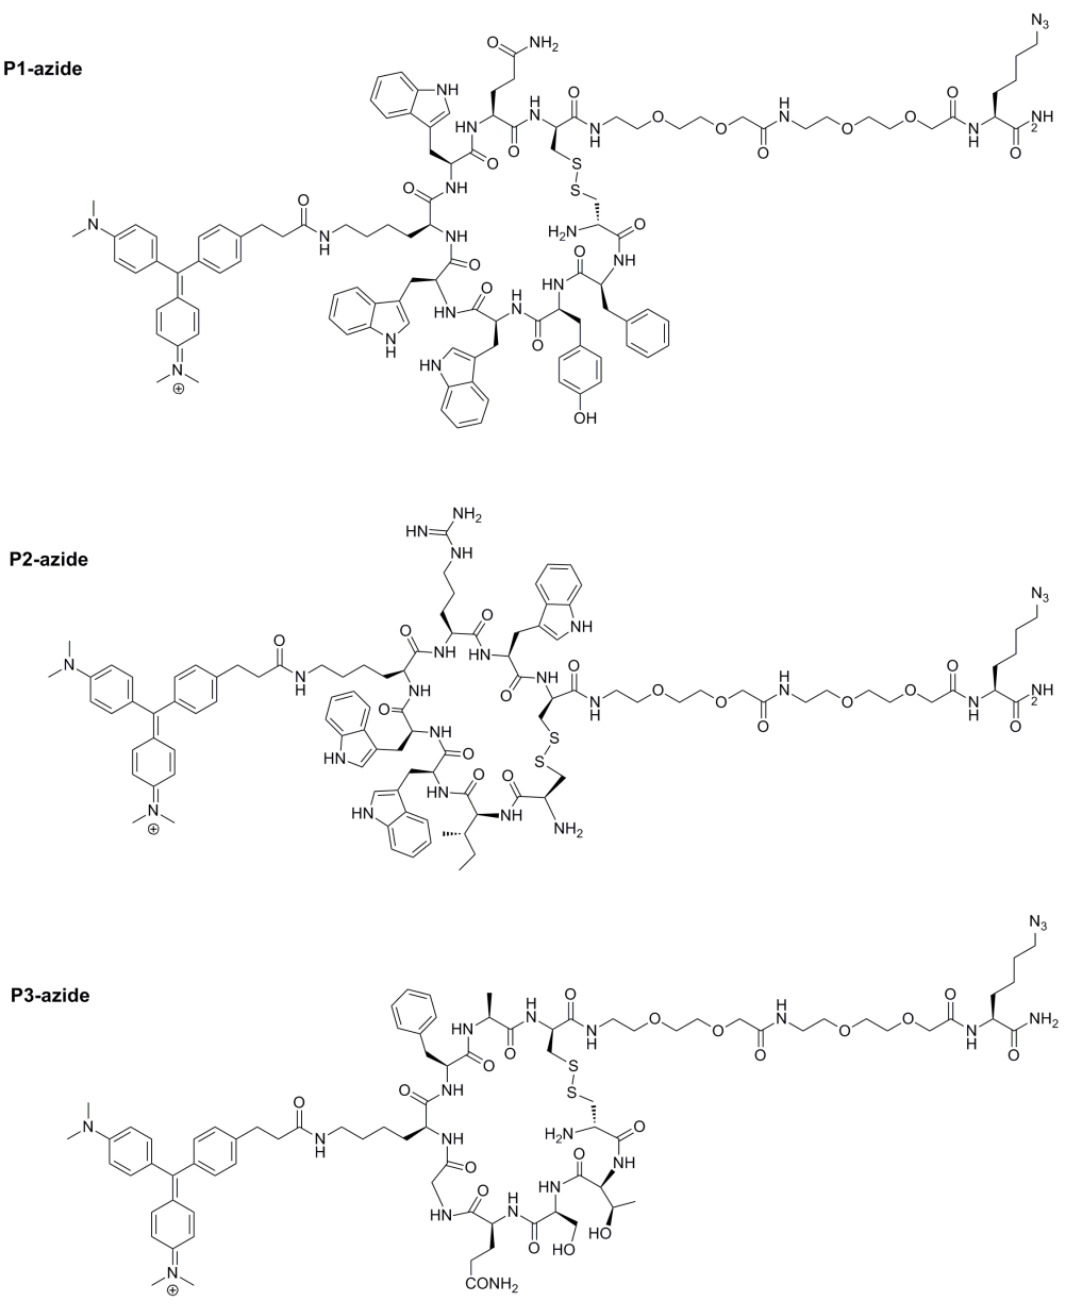
Figure 7. Structures of three azido-illuminating peptides from Table 1.